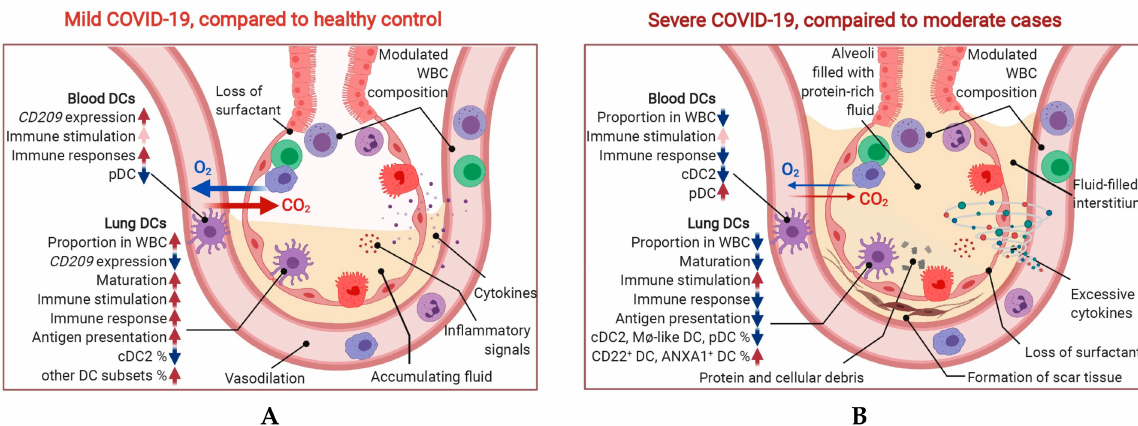
Figure 1. Graphical abstract. The findings from this study in lung and blood DCs were summarized for mild cases vs. healthy control ( A ) and severe cases vs. mild cases ( B ). Highlighted points are (1) SARS-CoV-2 modulates the DCs proportion and CD209 expression differently in lung and blood; (2) severe infection is characterized by DCs less capable of maturation, antigen presentation and MHCII expression; (3) the proportion of cDCs was decreased while that of pDC was increased in lung with SARS-CoV-2 infection but immature subsets (CD22 + /ANXA1 + ) were accumulated in severe